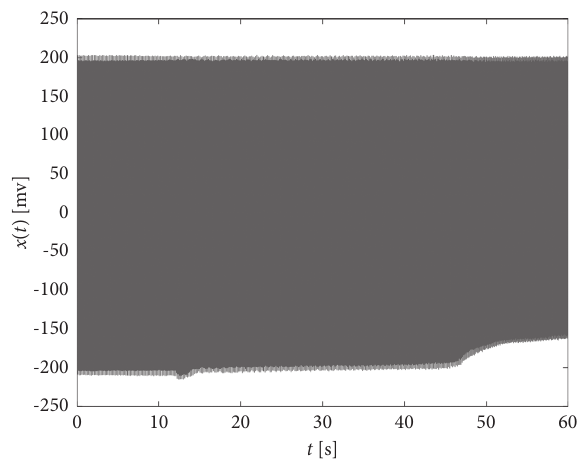
Figure 17: Time-varying speed of a propeller shaft.